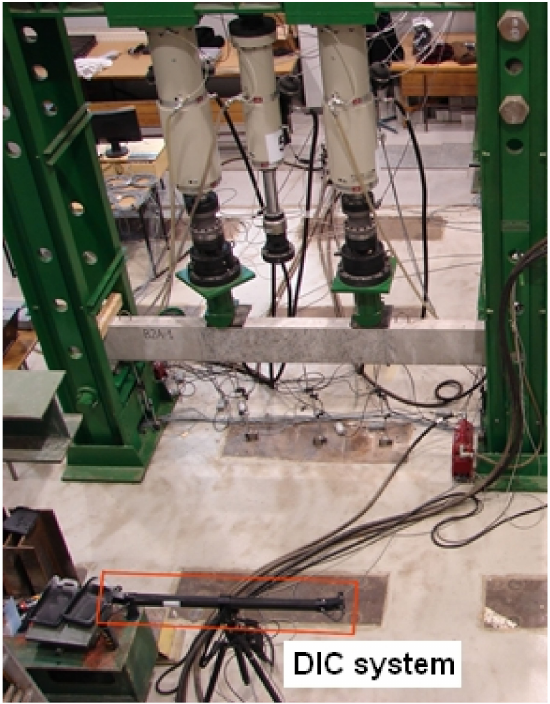
Figure 12. Photo of the test